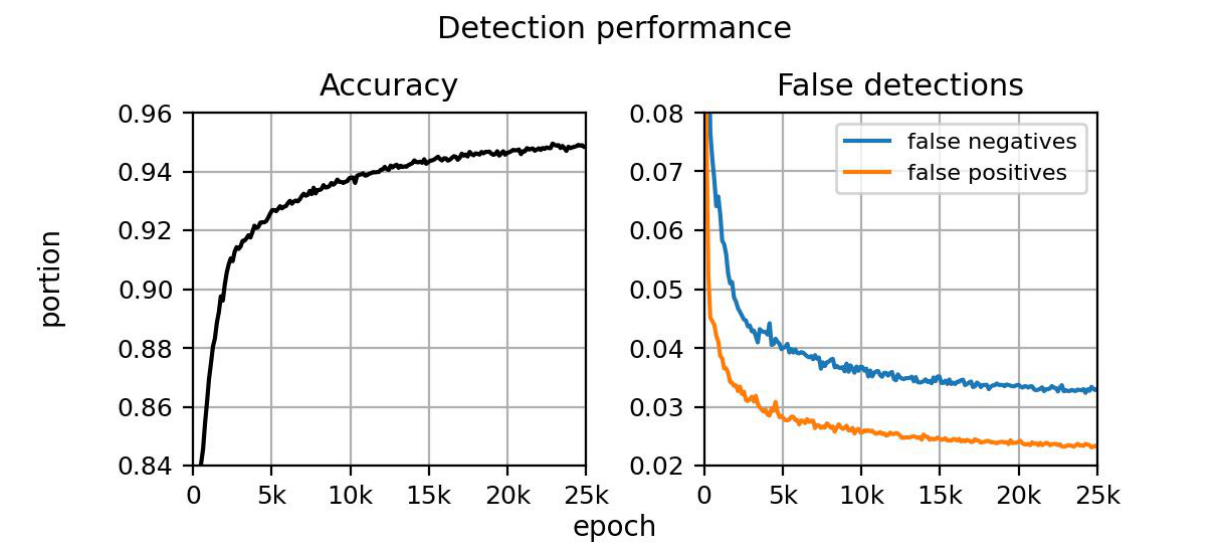
Figure 8. Accuracy and portion of incorrect detections during the NN training stage.